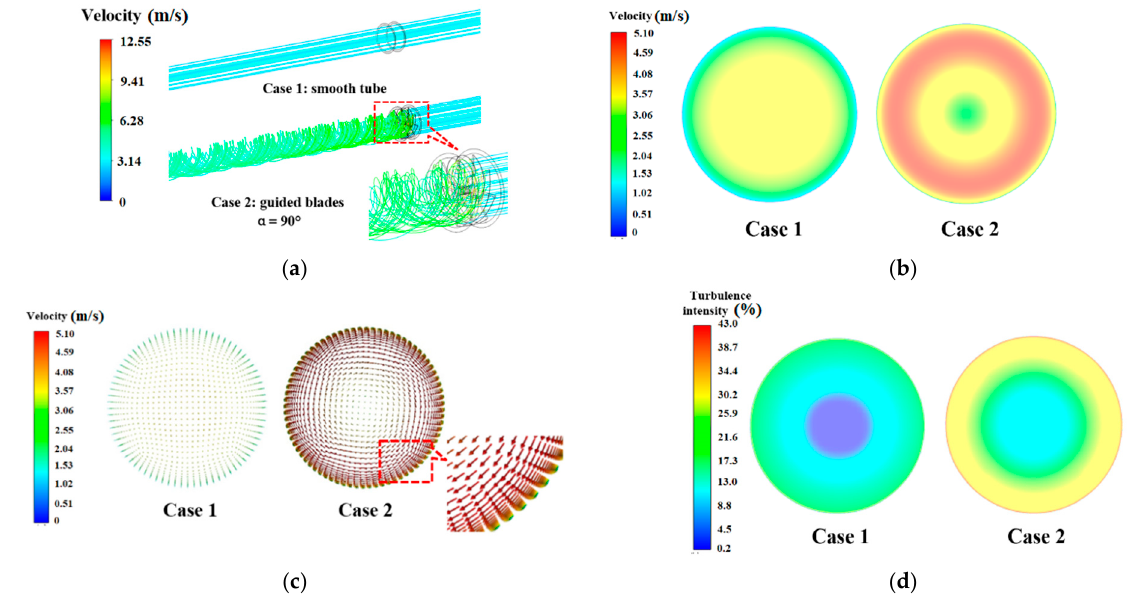
Figure 9. Velocity and turbulence intensity of the smooth tube and the tube with guide vanes with α = 90°: ( a ) flow streamlines; ( b ) total velocity magnitude; ( c ) vectors of total velocity; ( d ) turbulence intensity.